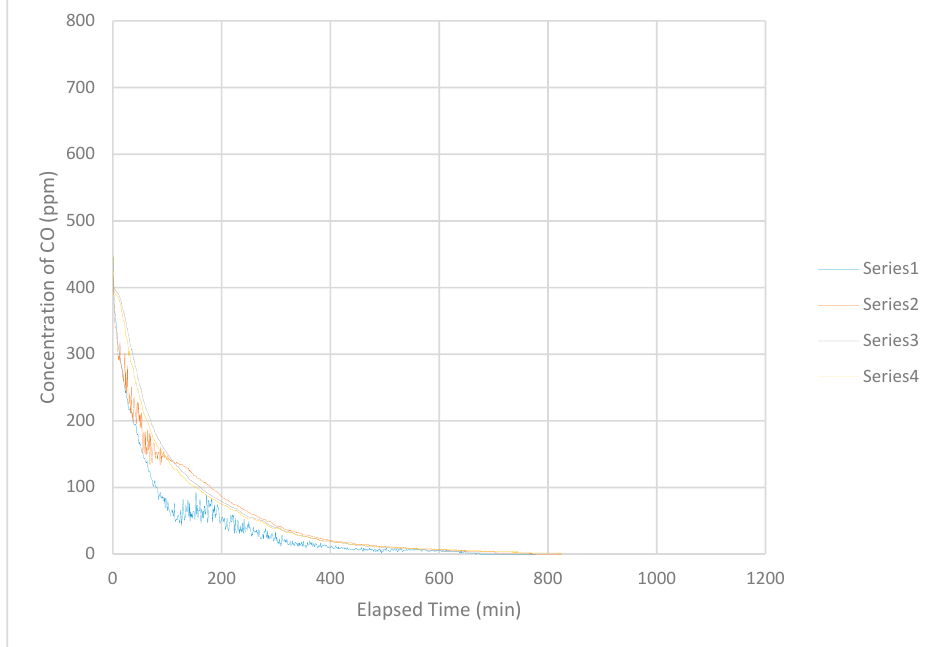
Figure 5. Disjointed decrease in concentration of CO in the airspace of the structure involving the top and second-level instruments (16 June 2015) that occurred during June and July. Sometimes, the disjointed decrease in concentration of CO involved the top and second instruments and on rare occasion, the third-level instrument (third from the top). Series 1 to Series 4 reflected the position of the instruments on the stand at 152 cm (60 in), 114 cm (45 in), 76 cm (30 in), and 38 cm (15 in) above the bottom,